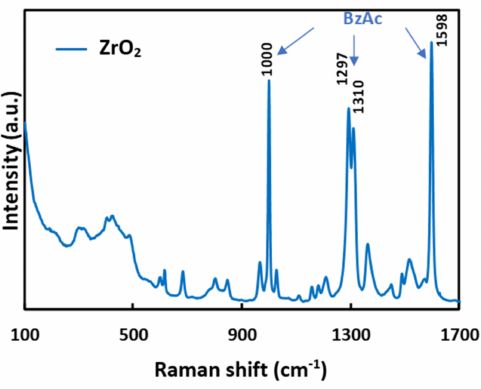
Figure 1. Raman spectrum of a ZrO 2 xerogel thin film deposited on SiO 2 substrate.